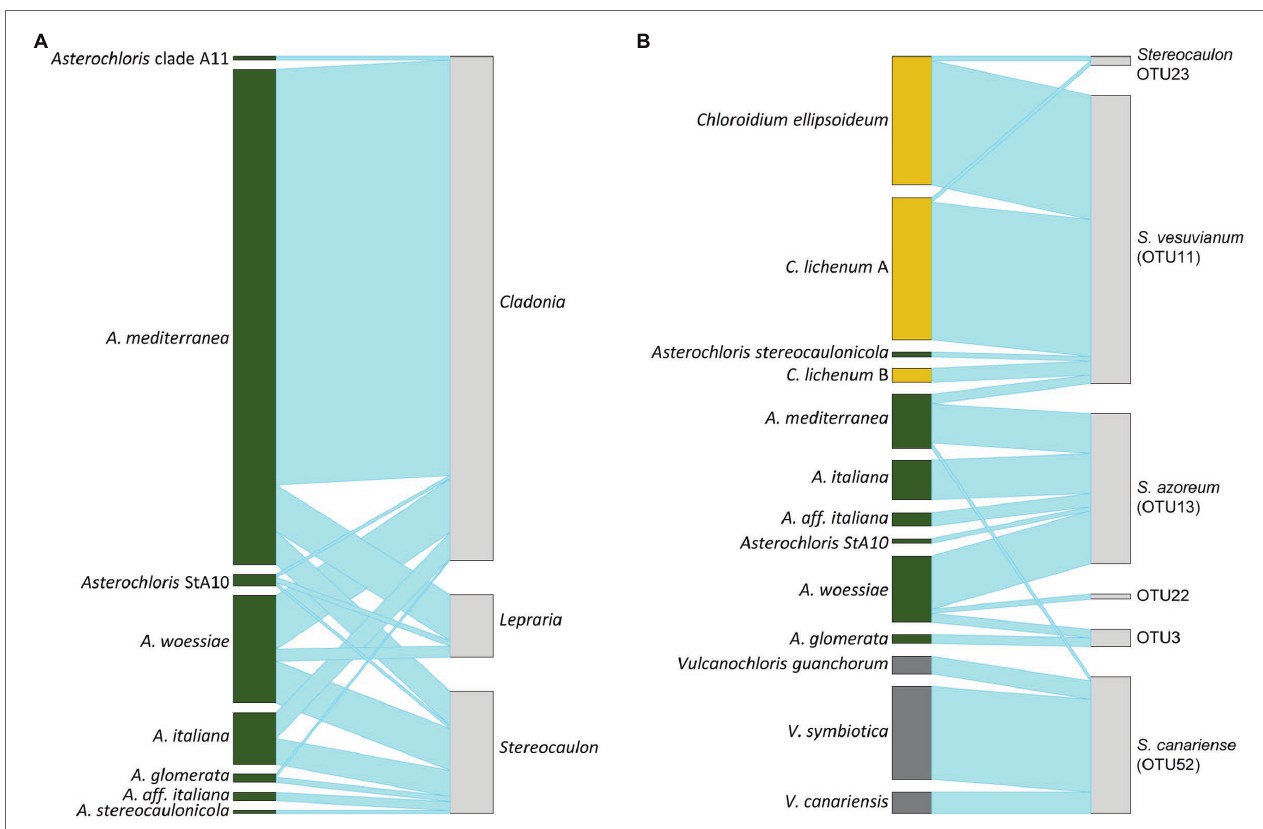
FIGURE 6 | Interaction network structures: (A) between phycobiont species-level lineages in the genus Asterochloris and mycobiont genera, (B) between phycobiont species-level lineages and mycobiont species-level lineages in the genus Stereocaulon . The width of the links is proportional to the number of specimens forming the